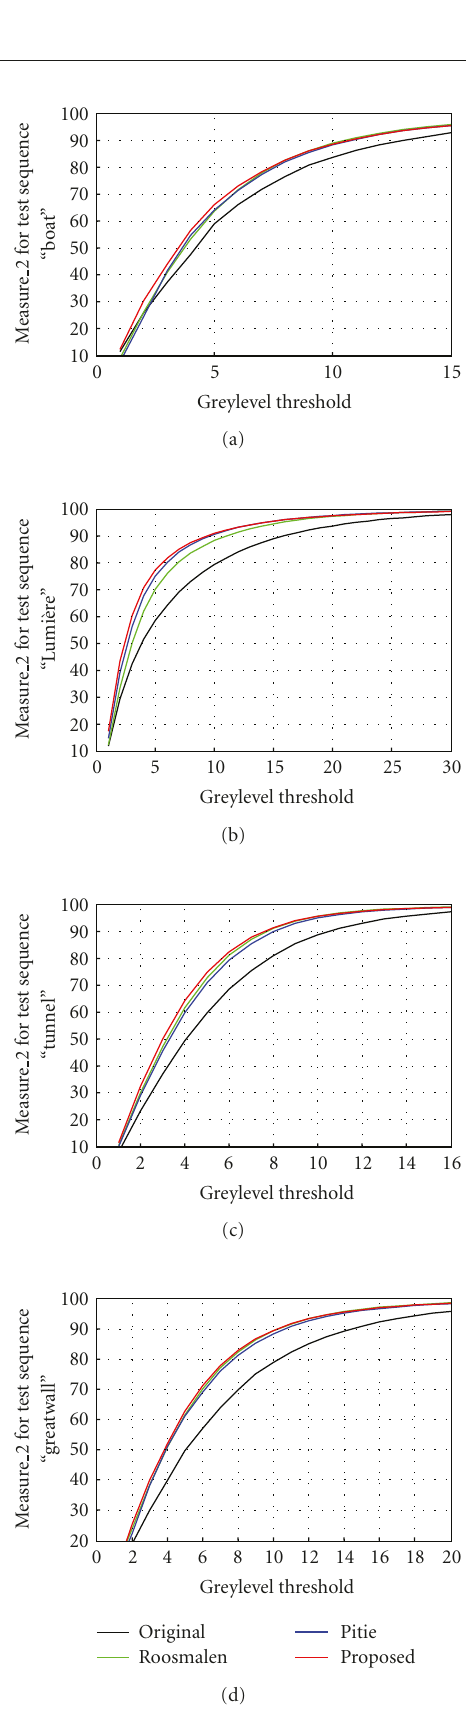
Figure 16: Comparison of percentage of motion-compensated pixels having an absolute di ff erence lower than a variable